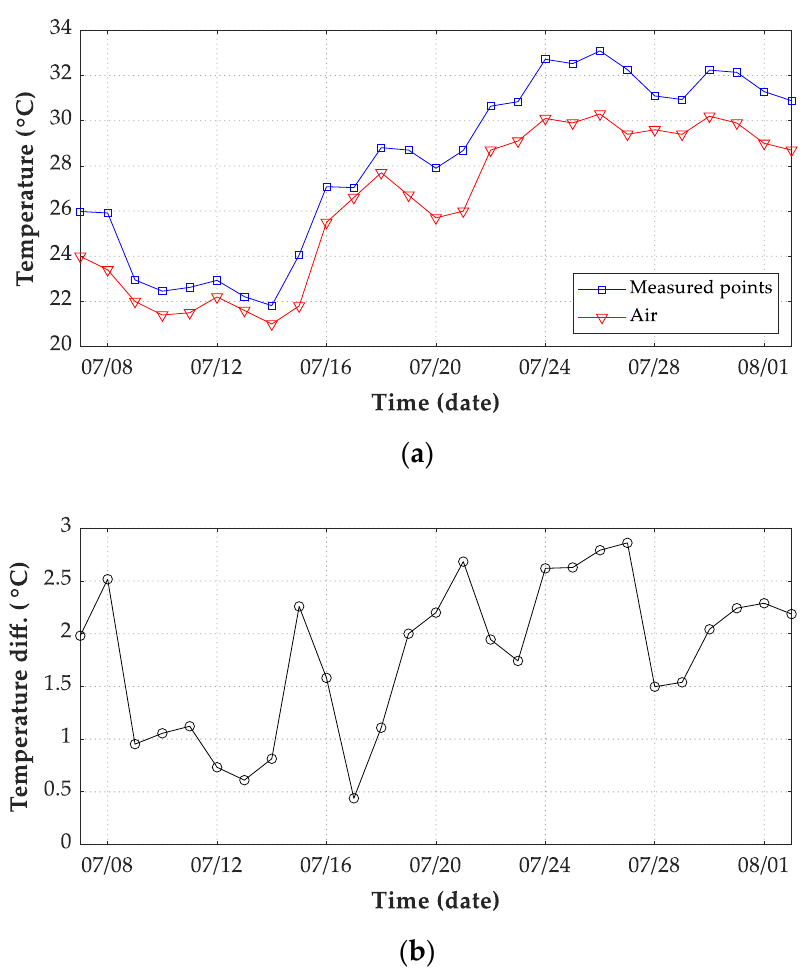
Figure 13. Daily air temperature records from 7 July 2019 to 2 August 2019. ( a ) Comparison between the average temperature of 6 measuring points with air temperature; ( b ) temperature difference (measured structural temperature minus air temperature).